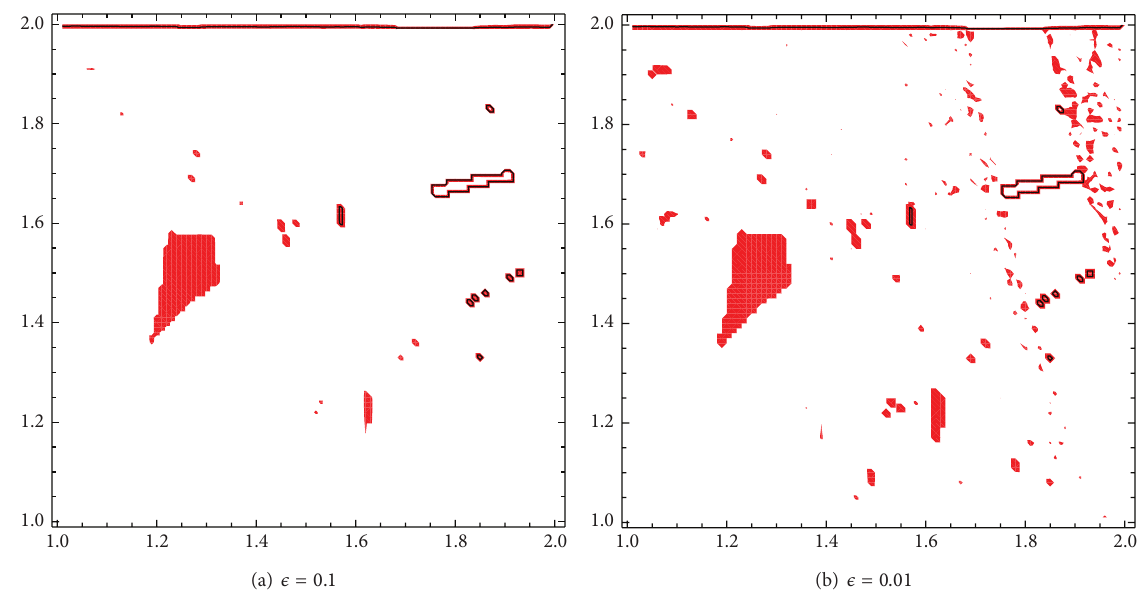
Figure 8: We compute (27) for samples of length 𝑛 = 10000 , 1 < 𝛼 , 𝛽 ≤ 2 , and constant step size ℎ = 0.01 for both 𝛼 and 𝛽 . The parameter 𝛼 is represented in 𝑋 -axis. We draw in red the values of (𝛼,𝛽) such that (27) is greater than a fixed value 𝜖 . In (a) 𝜖 = 0.1 , and for (b) 𝜖 = 0.01 .